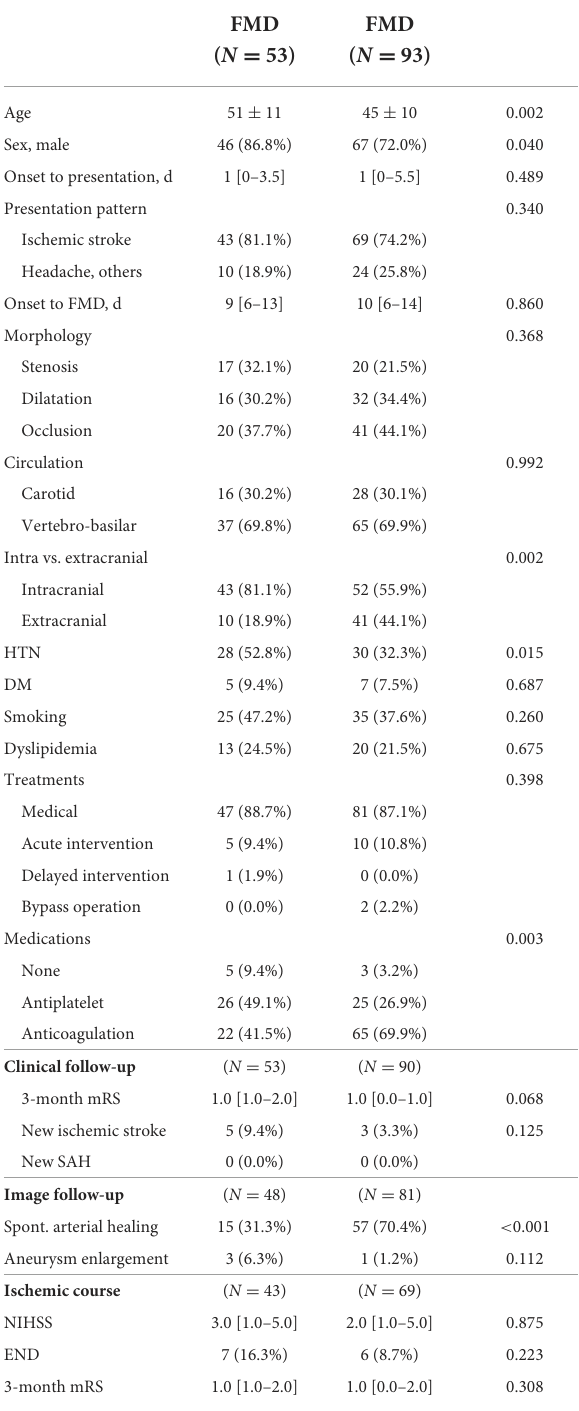
TABLE 1 Baseline profiles, treatment, clinical, and imaging characteristics according to dichotomized state of flow mediated dilatation.